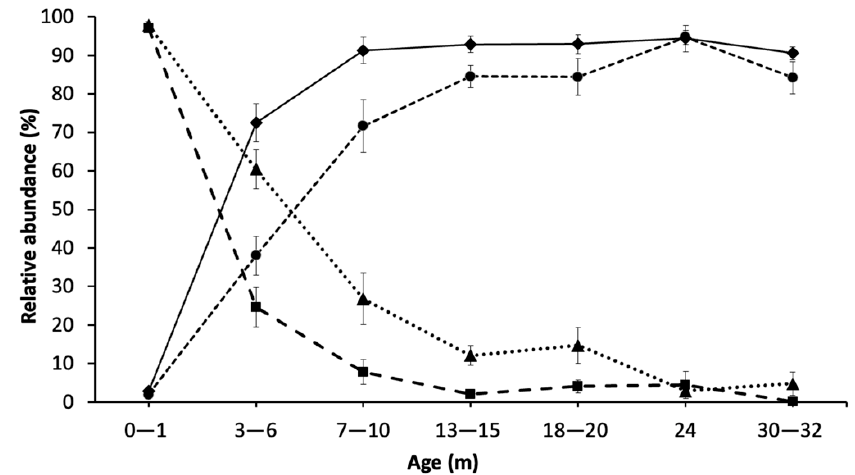
Figure 3. Relative abundance of Lactococcus spp. and NSLAB using 16S rRNA gene amplicon sequences for cheeses from 13 trials (% of total reads identified to genus level). Triangle symbol: Lactococcus non-PMA-treated total DNA; Square symbol: Lactococcus PMA-treated DNA (viable cells); Diamond symbol: NSLAB PMA-treated DNA (viable cells); Circle symbol: NSLAB non-PMA-treated total DNA. The genera compiled as NSLAB were: Lactobacillus , Lacticaseibacillus , Paucilactobacillus , Loigolactobacillus , Lentilactobacillus , Secundilactobacillus , Weissella , Streptococcus , Pediococcus , and Leuconostoc .